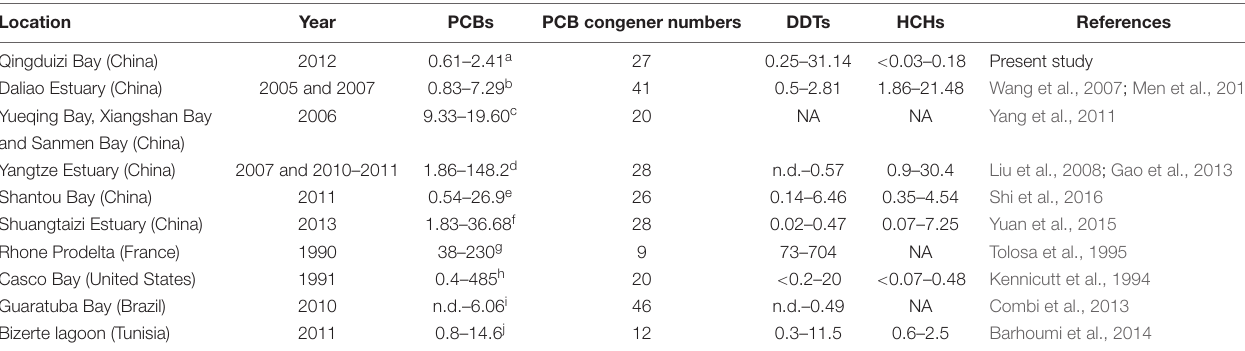
TABLE 1 | Levels of PCBs and OCPs in surface sediments from coastal area worldwide (ng g − 1 dw).